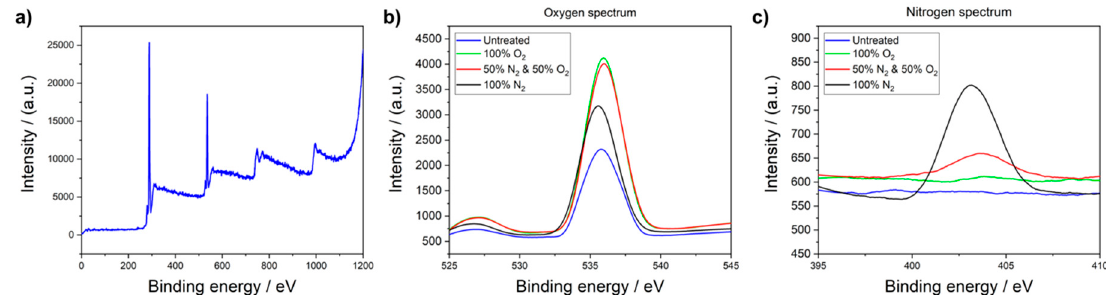
Figure 5. ( a ) XPS spectrum of an untreated PMMA foil. Detailed spectrum of ( b ) oxygen and ( c ) nitrogen content of plasma treated PMMA foils with different gas compositions (5 min, 1000 W, 80 °C). For the maximum oxygen content, a plasma atmosphere of 50% oxygen and 50% nitrogen is sufficient. Unlike the oxygen spectrum, in the nitrogen spectrum the highest peak is achieved by using 100% nitrogen for the plasma process.